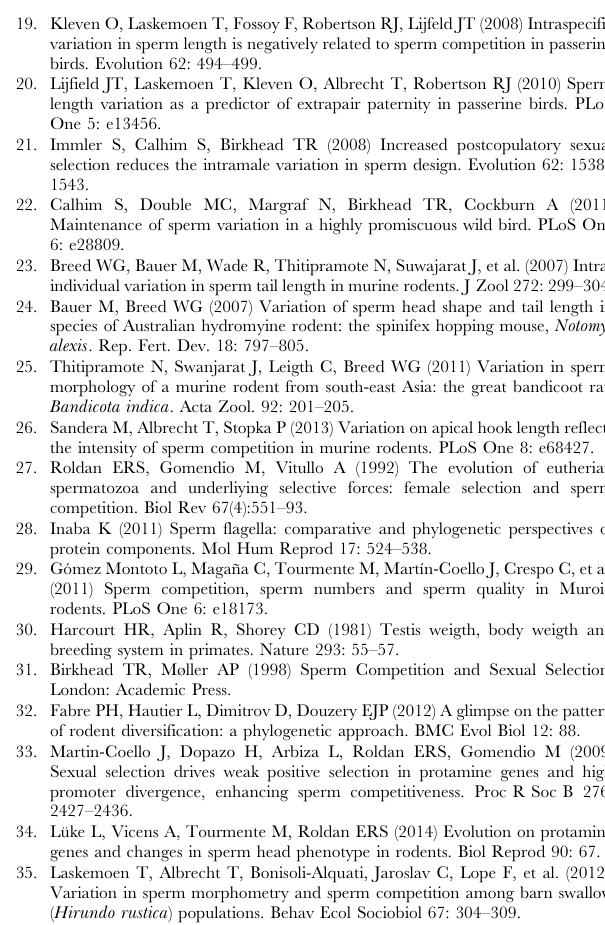
Table S1 Localities of origin of muroid rodents used in this study. Table S2 Intra-male coefficients of variation (CV) of sperm components in muroid rodents examined in this